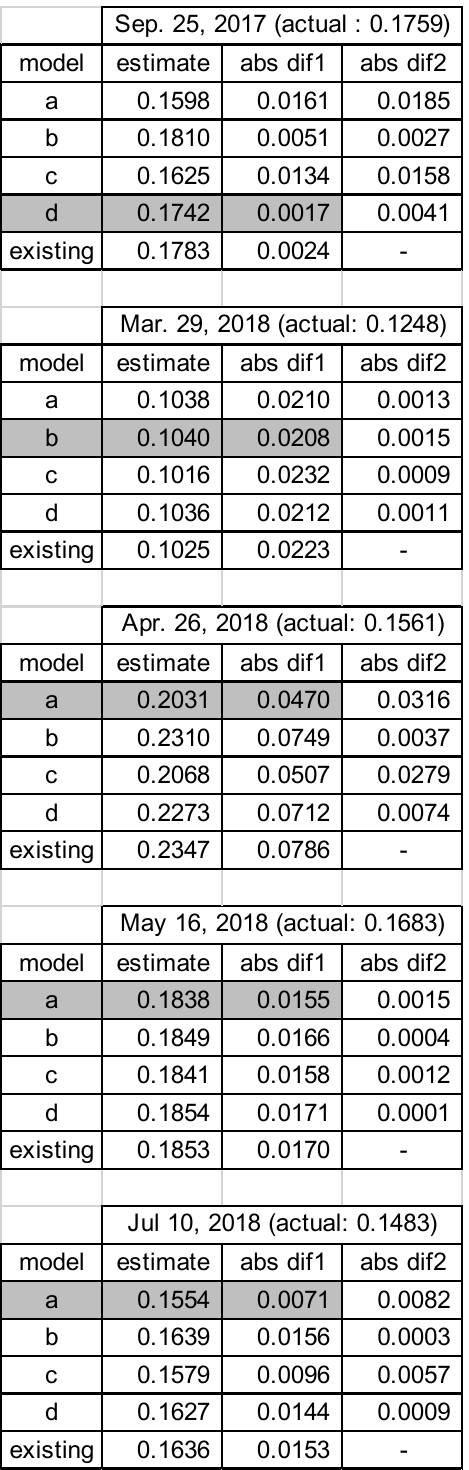
Table 3. Broadband albedo obtained by applying the NTB conversion formula reported by Liang (2000). Gray column denotes the best result. “Abs dif1” and “abs dif2” denote the differences from the actual value and from the value estimated using the existing model, respectively.